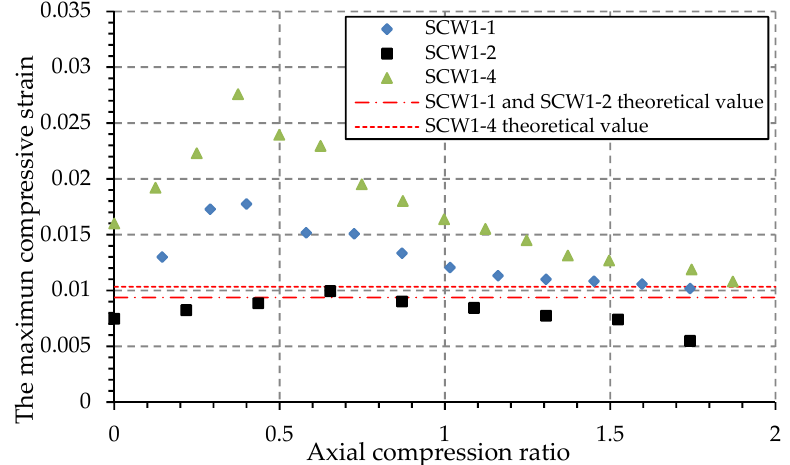
Figure 5. Maximum concrete compression strain versus axial compression ratio of specimens at ultimate load.